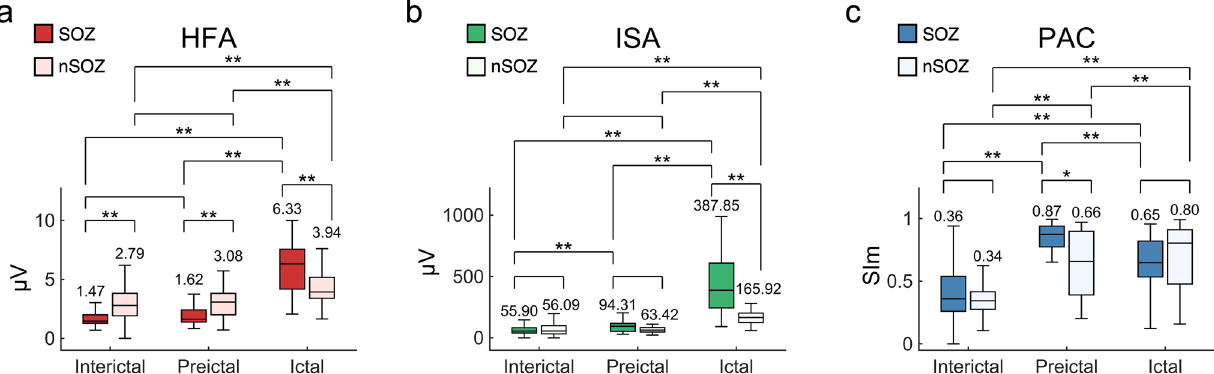
Figure 3. The profiles of HFA, ISA, and PAC. Results calculated from contacts placed in the SOZ and nSOZ are shown as box-and-whisker plots in which the median values at each group are displayed. ( a ) HFA amplitude of ictal-SOZ contacts achieved its maximum value and was significantly higher than that of interictal-SOZ contacts, preictal-SOZ contacts, and ictal-nSOZ contacts. ( b ) ISA oscillations of ictal-SOZ contacts achieved their maximum values and are significantly higher than those of interictal-SOZ contacts, preictal-SOZ contacts, and ictal-nSOZ contacts. ( c ) For PAC (i.e., ISA-HFA SIm), the SIm of the preictal-SOZ contacts achieves its maximum value and is significantly higher than that of interictal-SOZ contacts and ictal-SOZ contacts. Median values of each group are indicated as numerical values and the center mark on each box. *Corrected p < 0.05,